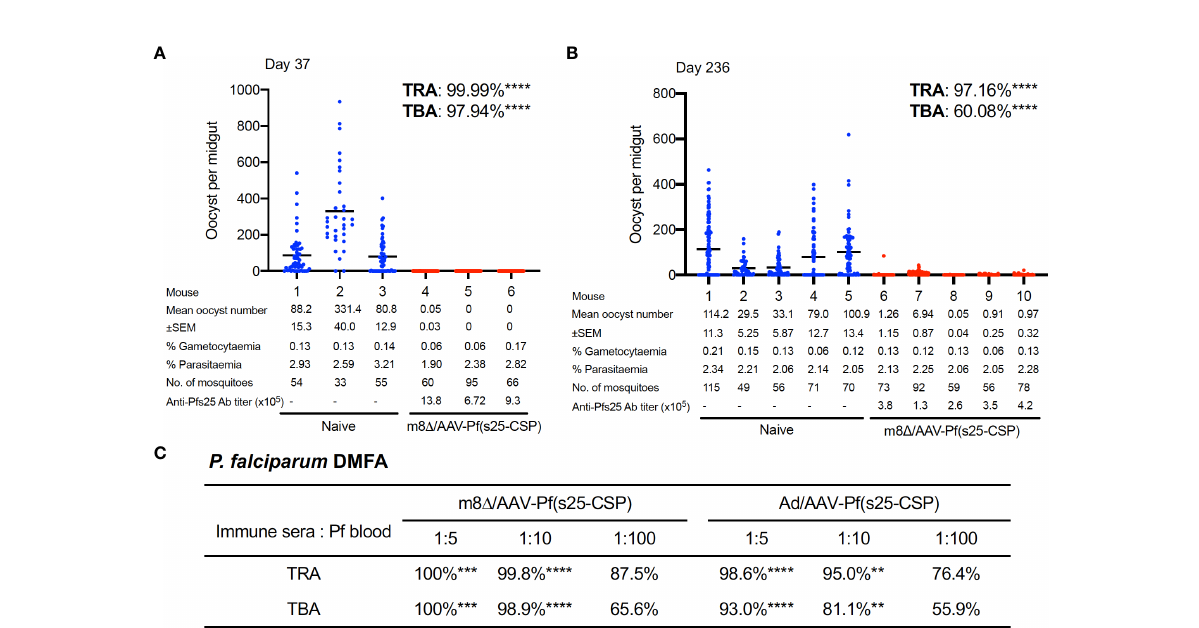
FIGURE 3 TB ef fi cacy. (A, B) TB ef fi cacy in mice immunized with m8 D /AAV-Pf(s25-CSP) at day 37 (A) , (n = 3) and day 236 (B) , (wn = 5) after the last immunization. Each data point represents the oocyst number from a single blood-fed mosquito and horizontal lines indicate the mean number. (C) The sera from immunized mice at day 115 after the last immunization were tested for a direct membrane feeding assay. A summary of the transmission-reducing activity (TRA) and TB activity (TBA) for the indicated dilution ratio of the sera from m8 D /AAV-Pf(s25-CSP) and Ad/AAV-Pf (s25-CSP) is shown. P values were calculated either using Mann – Whitney tests for TRA or Fisher ’ s exact probability tests for TBA versus the control groups. **p < 0.01; ***p < 0.0001; ****p <